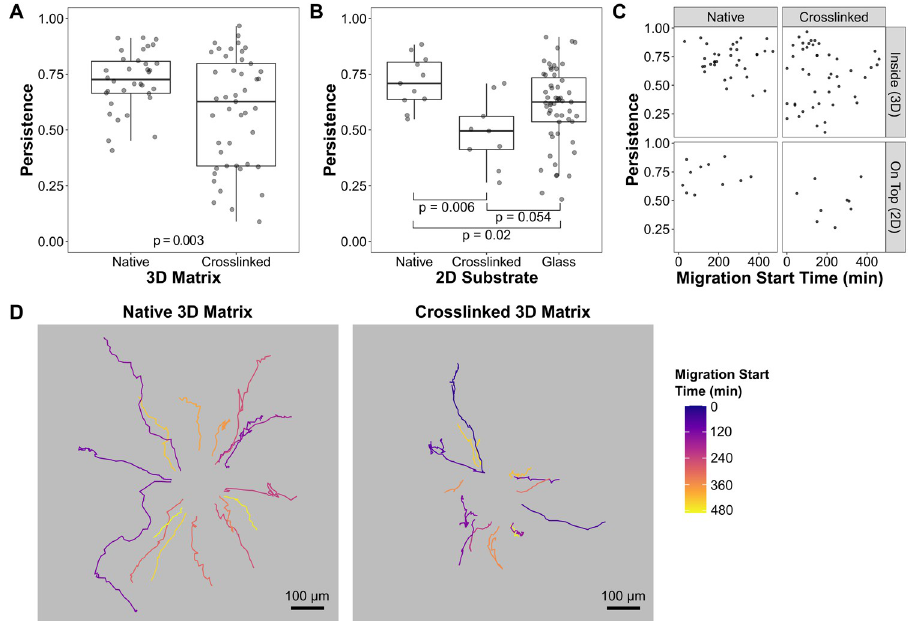
Fig 4. Matrix crosslinking decreases cell migration persistence. Cell emigration out of spheroids was tracked over time. For persistence calculations, tracks were truncated to four hours. ( A ) The average persistence of cells in native matrices is significantly higher than that of cells in crosslinked matrices (p = 0.003; two-tailed t-Test; n = 34 native, 45 crosslinked cells). Box-and-whisker plot: dark line indicates median; box encompasses 25th-75th percentiles; whiskers extend to the largest value no larger than 1.5 times the box width (interquartile range). Each dot represents data from an individual cell from one of four independent experiments. ( B ) Identical experiment to (A) except that spheroids were seeded on top of native and crosslinked matrices rather than embedded within them. Cells on native matrices were more persistent than those on crosslinked matrices (p = 0.006; two-tailed t-Test; n = 11 native, 9 crosslinked). The average persistence of cells migrating out of spheroids onto glass coverslips was in between that of cells on the matrices, significantly different from native (p = 0.02), but only marginally significant from crosslinked (p = 0.054). P-values were adjusted for multiple comparisons using the Benjamini-Hochberg (false discovery rate) method. Data are from three independent experiments. ( C ) Persistence data from (A; “inside”) and (B; “on top”) plotted as a function of the time at which the cell began to be tracked. Cells exited the spheroid throughout the 12 h incubation and tracking began as soon as they could be distinguished from the spheroid. Time 0 is the beginning of the timelapse recording, not the time of seeding. There is no correlation between persistence and time of track initiation for any of the four datasets (Spearman’s Rank Correlation: crosslinked-inside, rho = -0.06, p = 0.72; native-inside, rho = 0.01, p = 0.95; crosslinked-ontop, rho = 0.08, p = 0.84; native-ontop, rho = 0.26, p = 0.45). ( D ) Migration paths of cells from representative native and crosslinked movies (same source data as panel A). The paths are color-coded based on the time at which the cell began to be tracked. Paths begin at the center. Cell paths are mostly distinct, although short sections of path overlap are occasionally observed. Scale bar, 100 μ m.